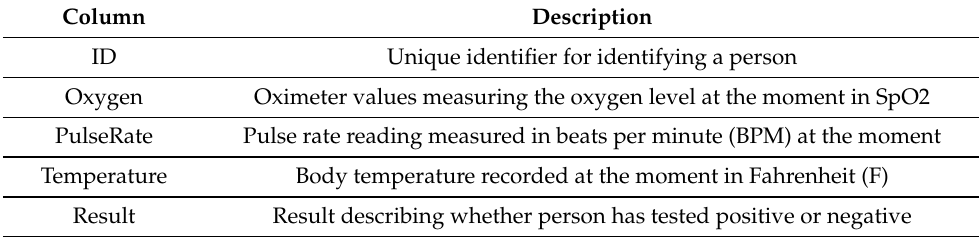
Table 2. Features of the dataset. Column Description